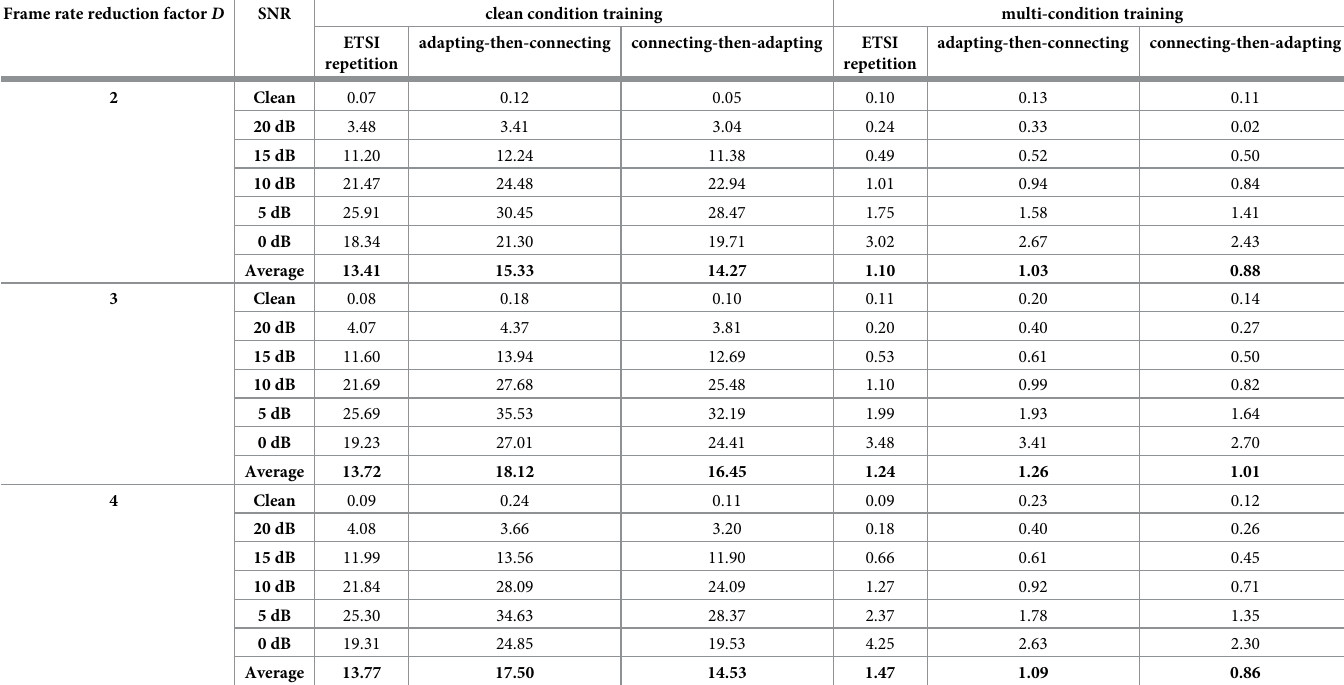
Table 2. Insertion error rate for the ETSI repetition and the two adaptation approaches. Frame rate reduction factor D